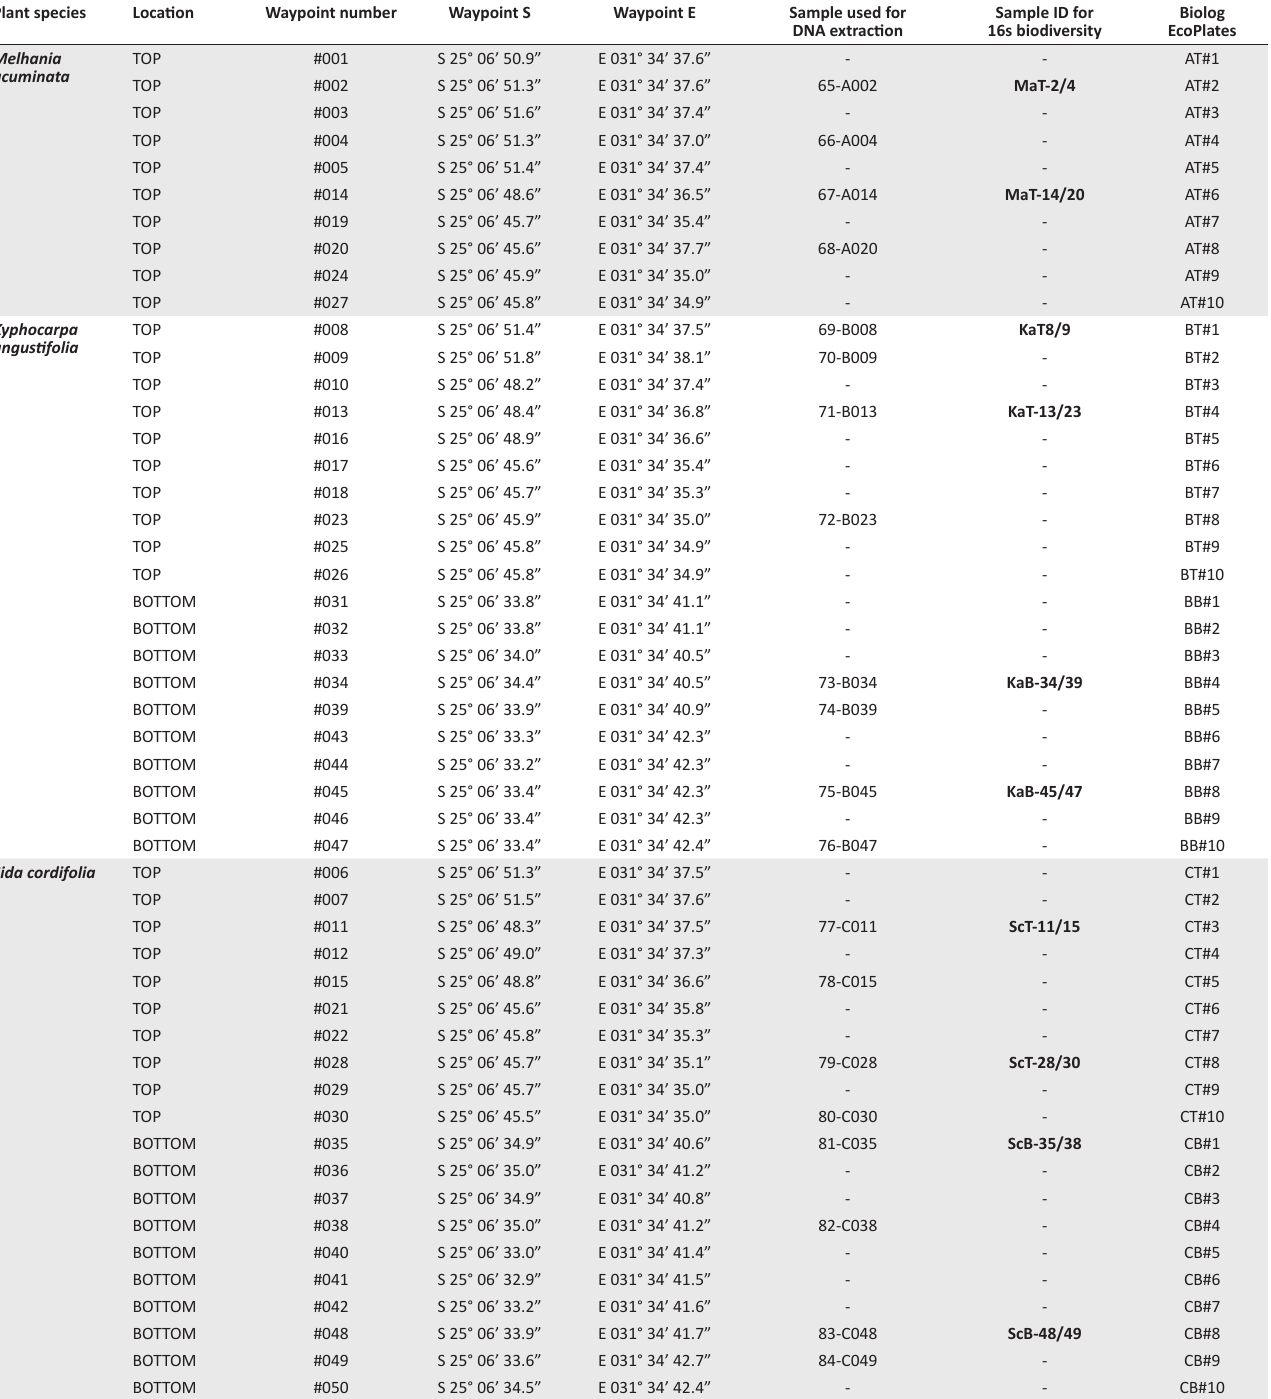
TABLE 1: Plant species and Global Positioning System location on granite catena for rhizosphere soil samples analysed by means of Biolog EcoPlates TM and 16S microbial diversity. Plant species Location Waypoint number Waypoint S Waypoint